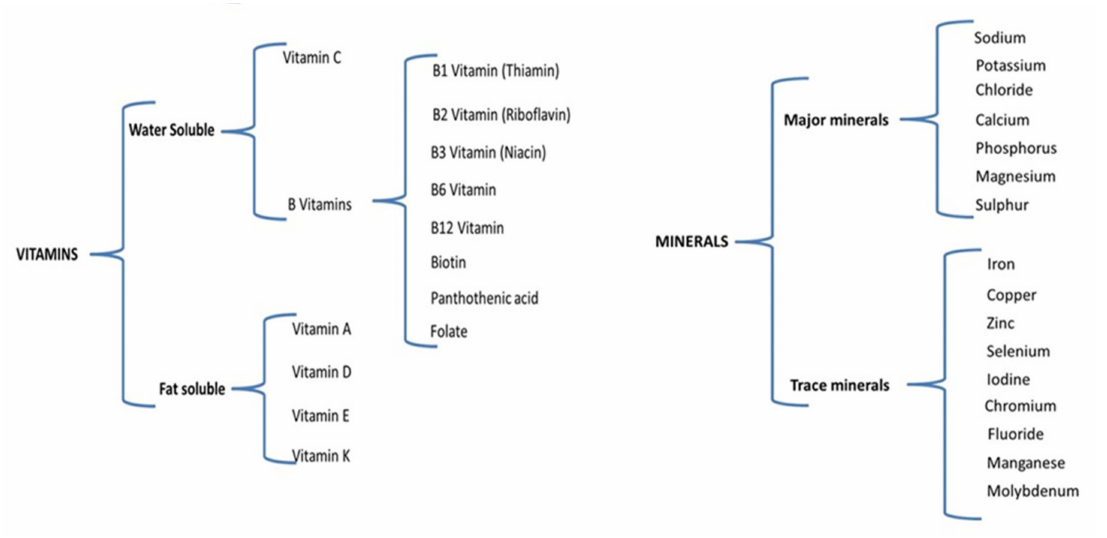
Figure 1. Vitamin and mineral